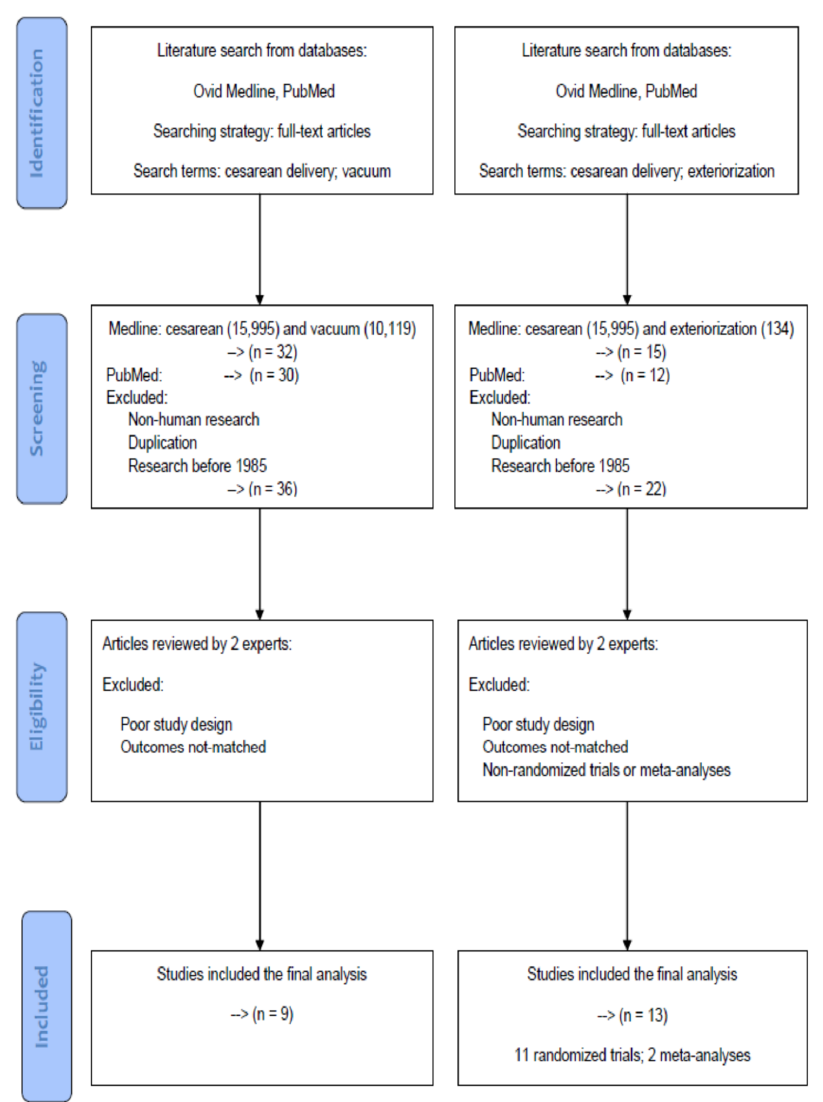
Figure 1. A flowchart of article selection to illustrate the processes of database identification, article screening, consideration of eligibility, and final inclusion according to the PRISMA statement.